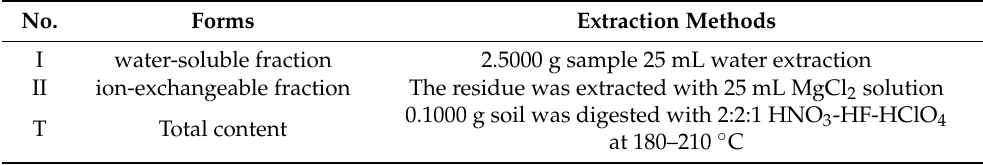
Table 2. Methods used to process soil samples in the current